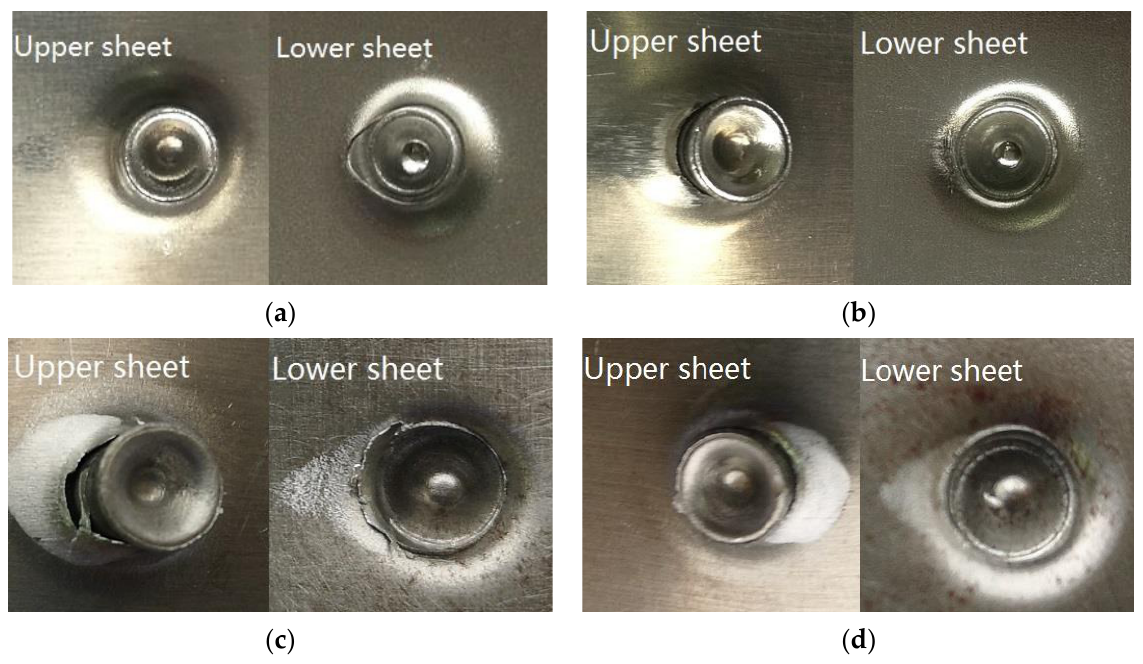
Figure 8. Failure forms of AA-SPFC joints at rivet heights of ( a ) 6 mm; ( b ) 7 mm; ( c ) 8 mm; ( d ) 9 mm.